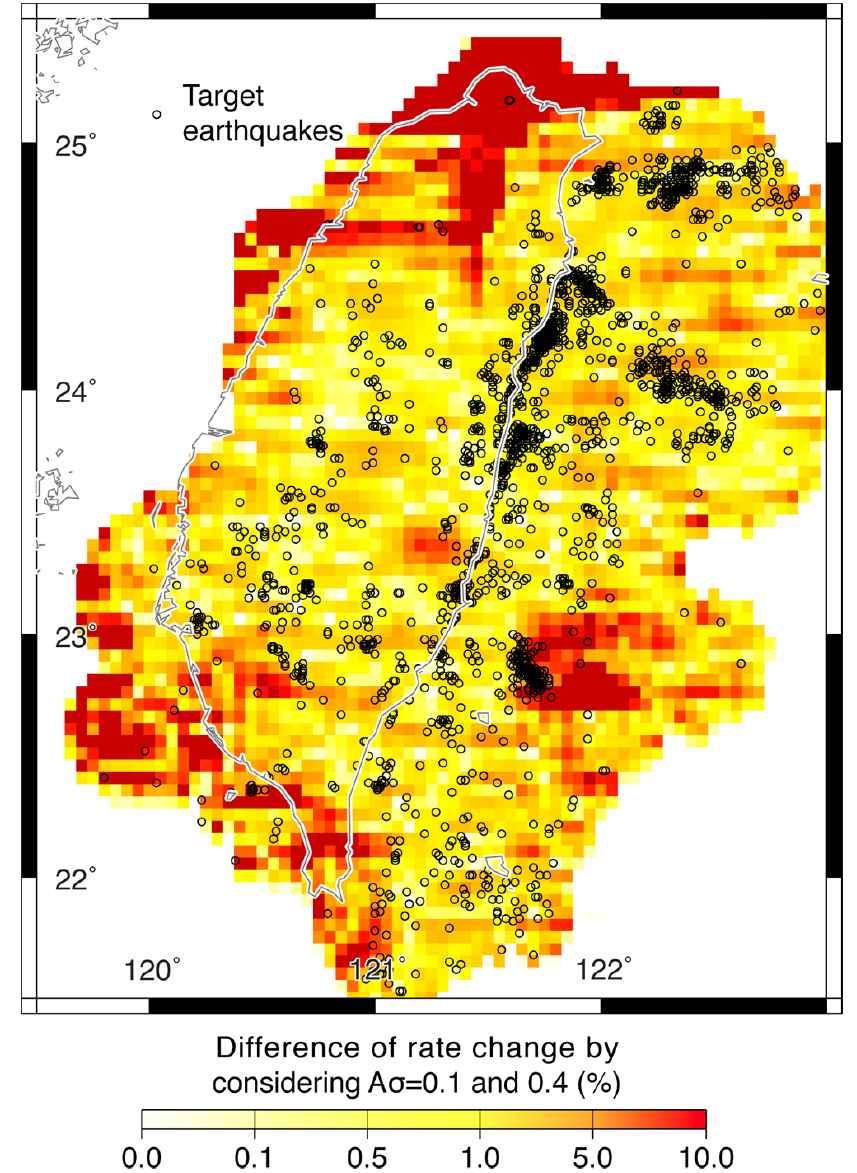
Fig. 7. The difference in the seismicity density rate by considering the upper and lower bounds of the 95% confidence interval for the bandwidth function, as shown in Fig. 5. Target earthquakes are shown as open